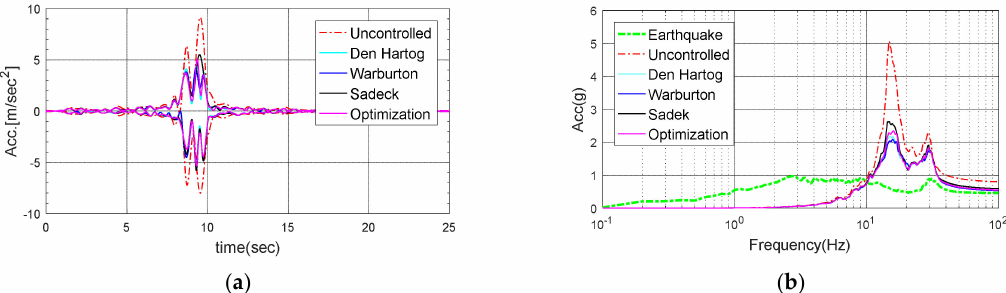
Figure 22. Response of the electrical cabinet subjected to Northern Calif-01: ( a ) Time history; ( b ) Response spectrum.